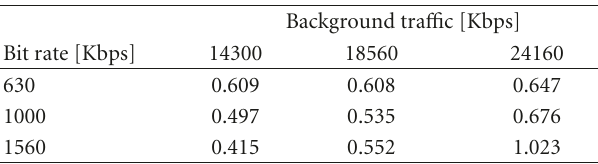
Table 7: PQoS Values estimated with the analytical model, signal power level − 15 dBm.